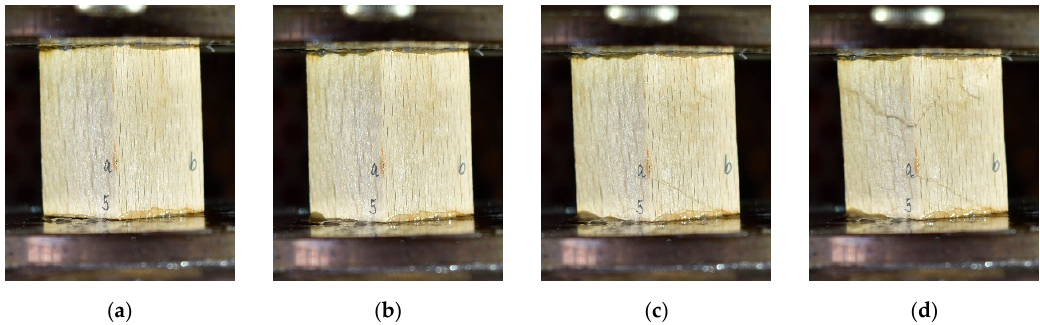
Figure 5. Deformations of beech specimen in QTLD at different times of ( a ) 0 s, ( b ) 6.5 s, ( c ) 12 s, and ( d ) 14 s.